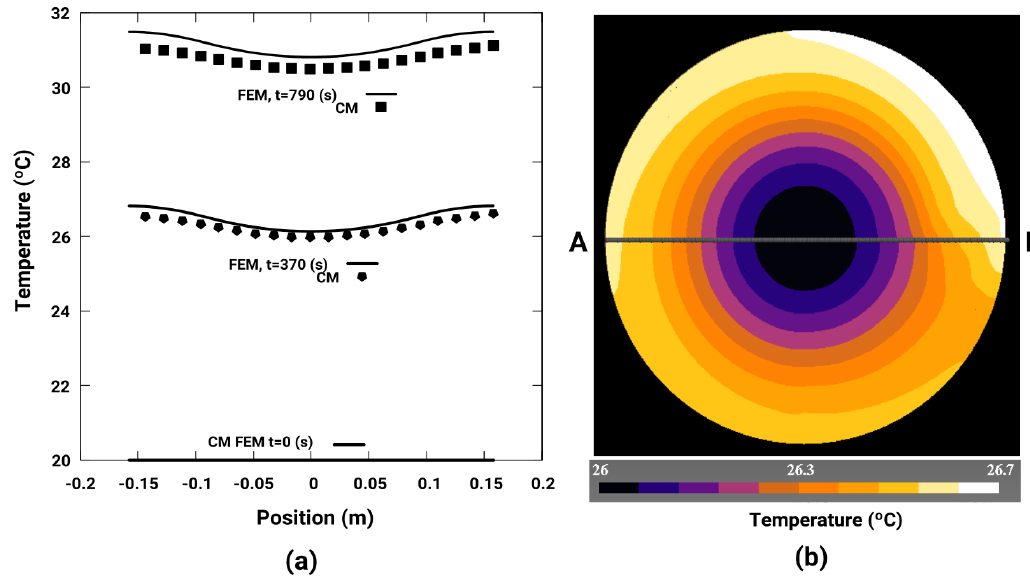
Figure 12. ( a ) Temperature distribution in section A-B at instants t = 0, 370 and 740 s for CM and FEM; ( b ) Surface distribution of the temperature at time t = 370 s for h eff = 10 W/m 2 K , w r = 11 rad / s and d = 6 mm, calculated with CM.